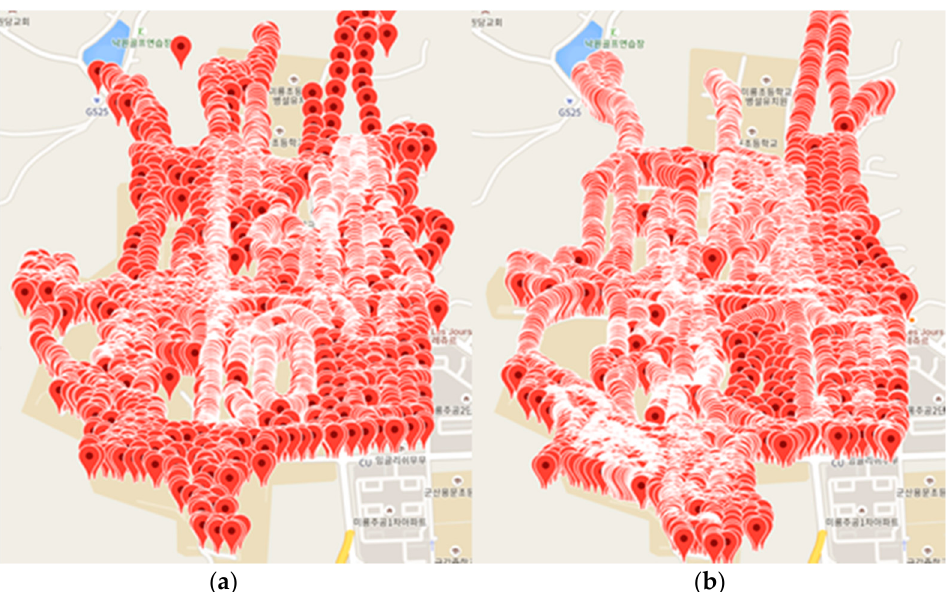
Figure 7. Results of measuring signal strength: ( a ) SKTelecom and ( b ) KT.